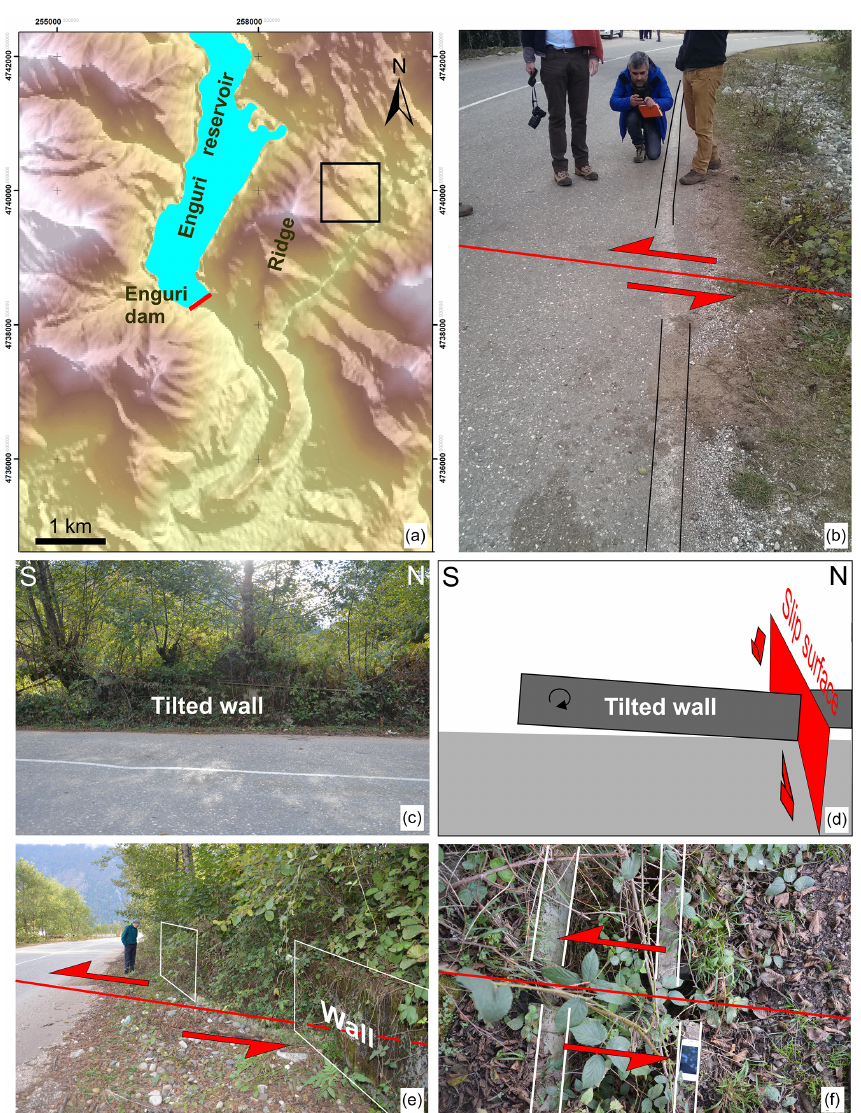
Figure 9. Features observed of the eastern landslide, located in the box shown in (a) . (b) Left-lateral offset of the Jvari–Khaishi–Mestia road white strip. (c, d) Photo and interpretation of the tilted wall along the same road. (e) Left-lateral offset of 1.9m of a 1974CE wall. (f) Left-lateral offset of a recent water